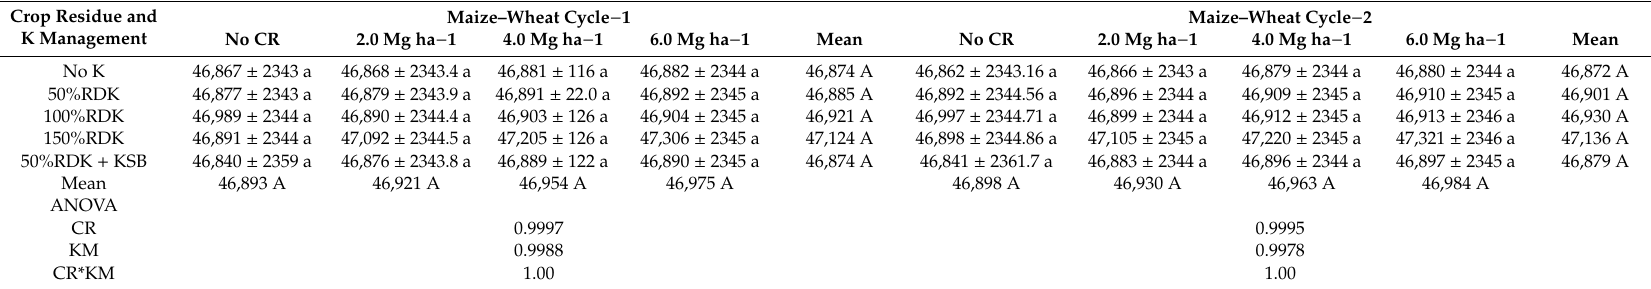
Table 6. Crop residue and potassium management practices on total potassium (kg ha − 1 ) at the end of each cropping cycle under zero tillage maize–wheat system. Crop Residue and K